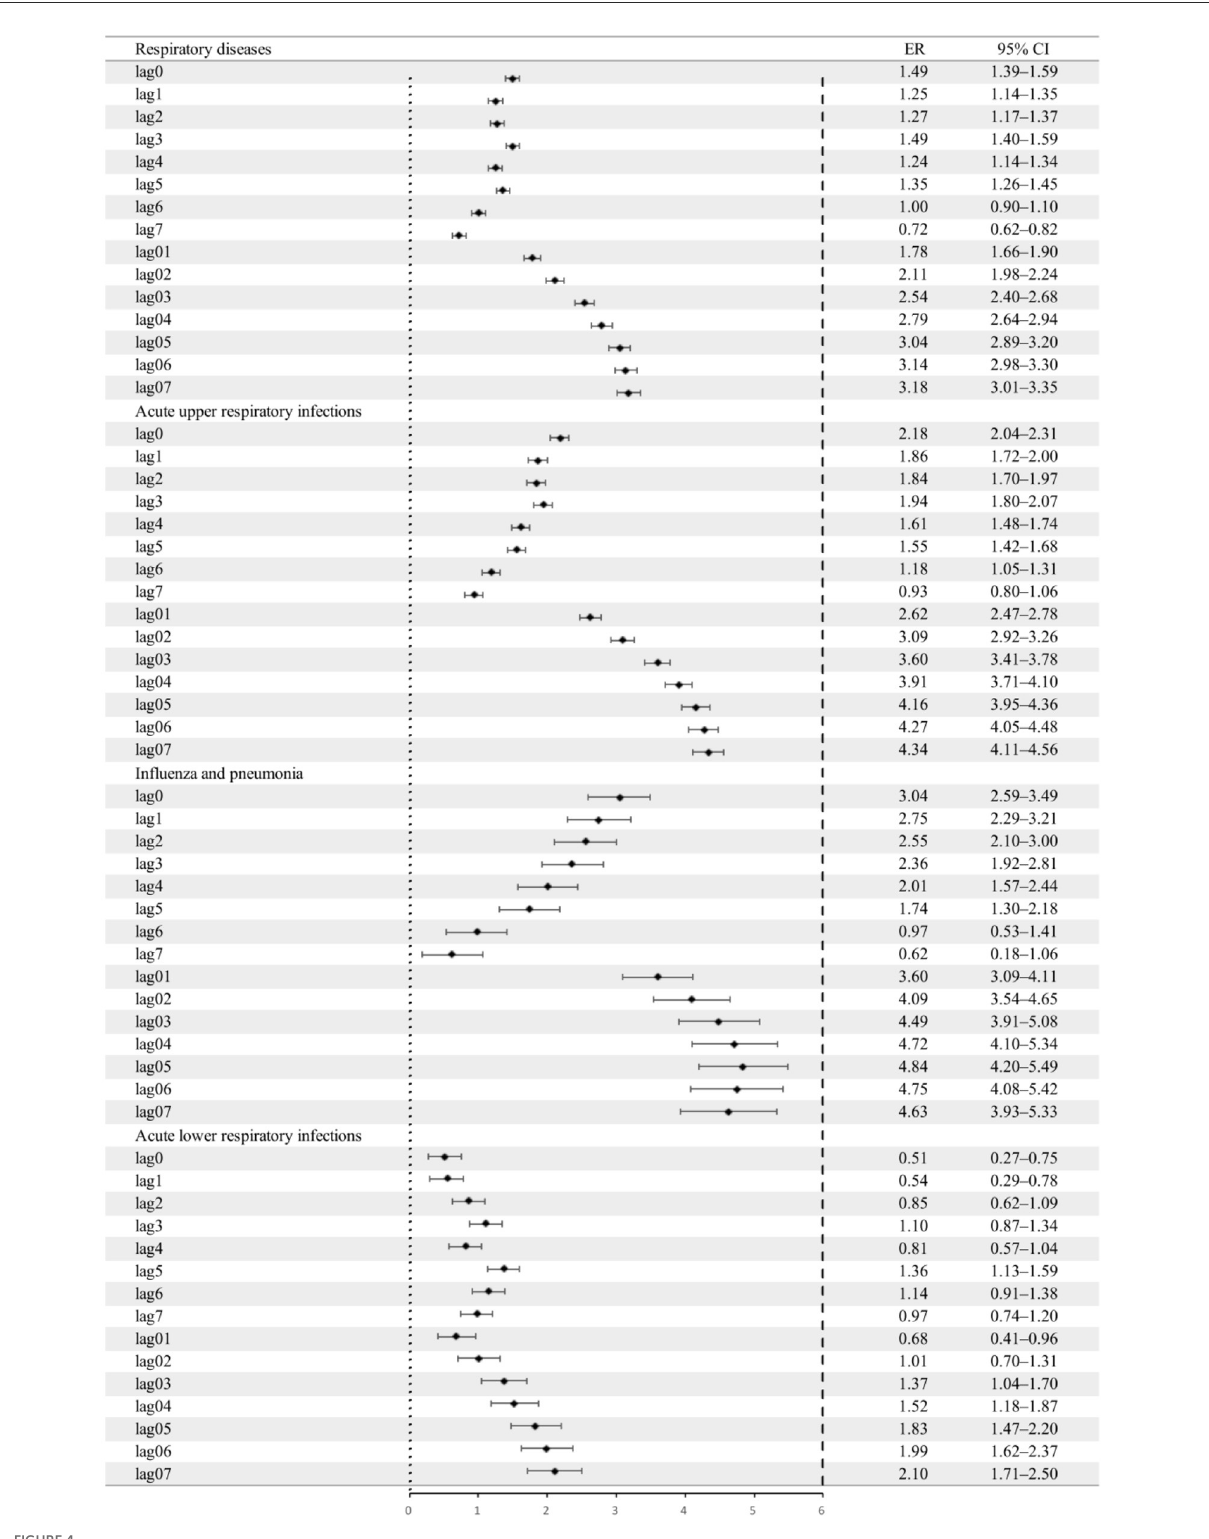
FIGURE4 Excess risk and 95% CI s for the percentage increase in outpatient visits for respiratory diseases per 10 µ g/m 3 increase in the concentration of PM 2.5 . CI , confidence interval, the black dot indicates the mean excess risk, the black vertical line corresponds to 95% CI , and the vertical dotted line at 0 represents the reference